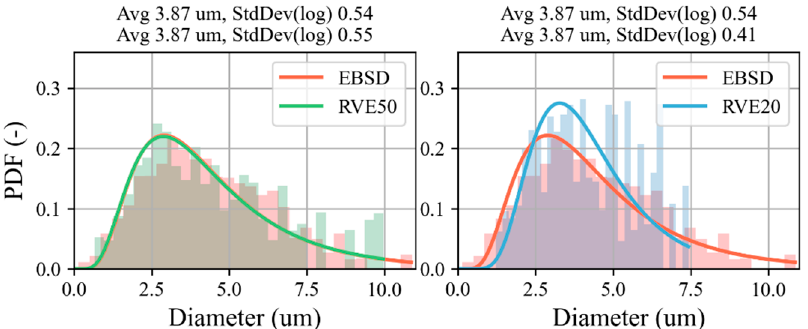
Figure 5. Grain size distribution calculated the RVEs shown in Figure 4 compared with the distribution obtained from the EBSD measurment. The corresponding fitted lognormal distribution is represented with a continuous line.